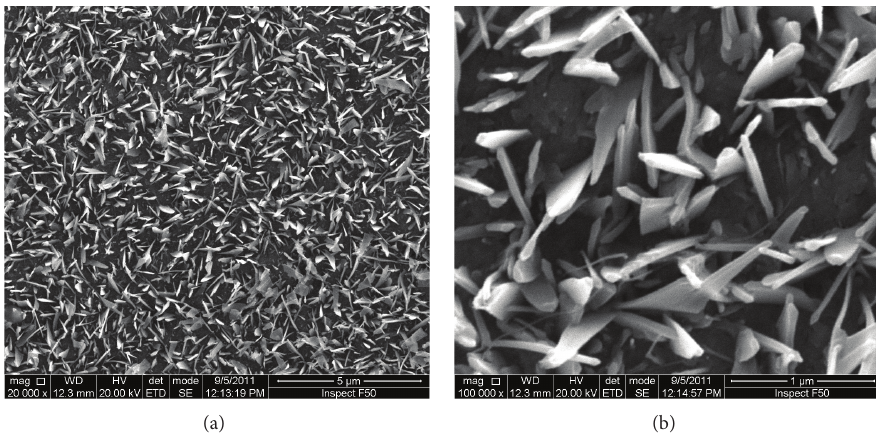
Figure 1: SEM images of iron oxide films of nanoflakes. (a) Low magnification and (b) high